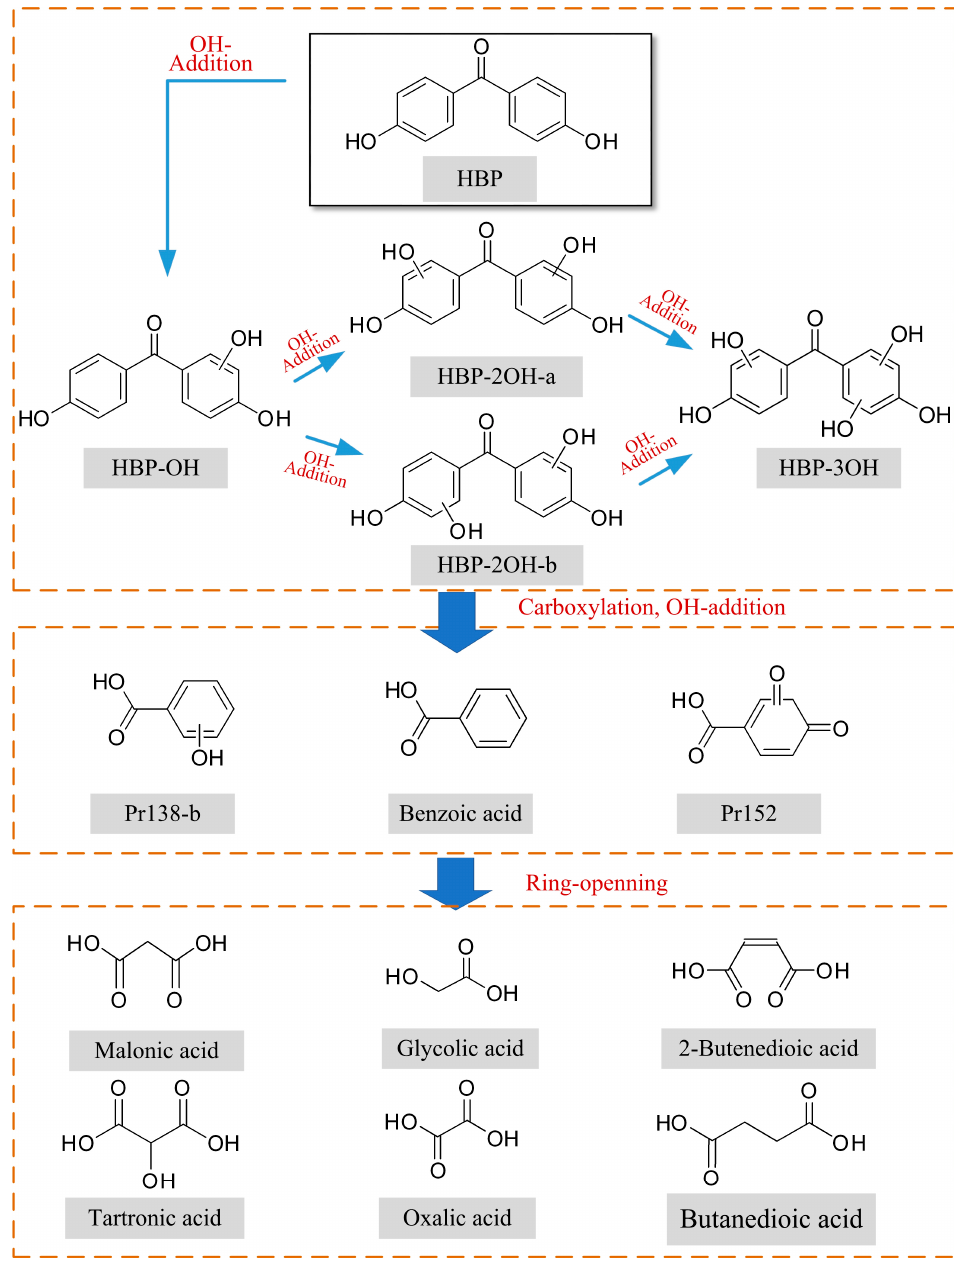
Figure 10. Proposed pathway of HBP degradation by the UV/H 2 O 2 process.